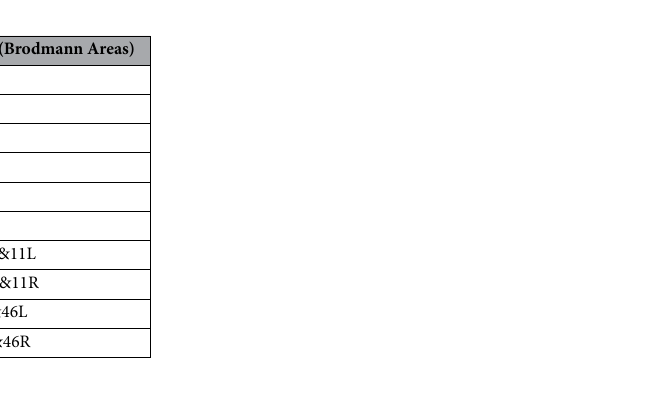
Table 1. Selected ROIs and